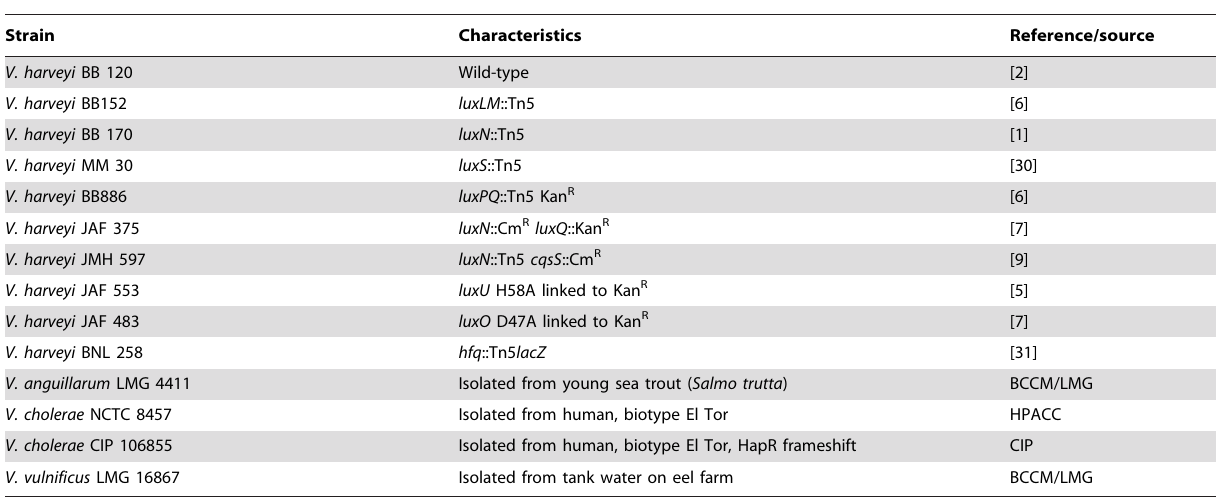
Table 2. Vibrio strains used in this